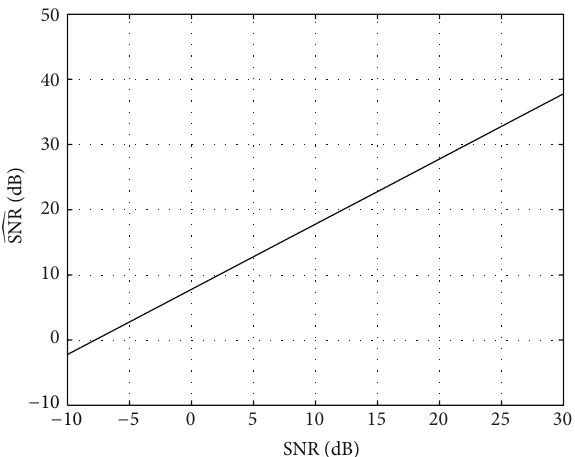
̂ SNR ( dB ) ) as a function of